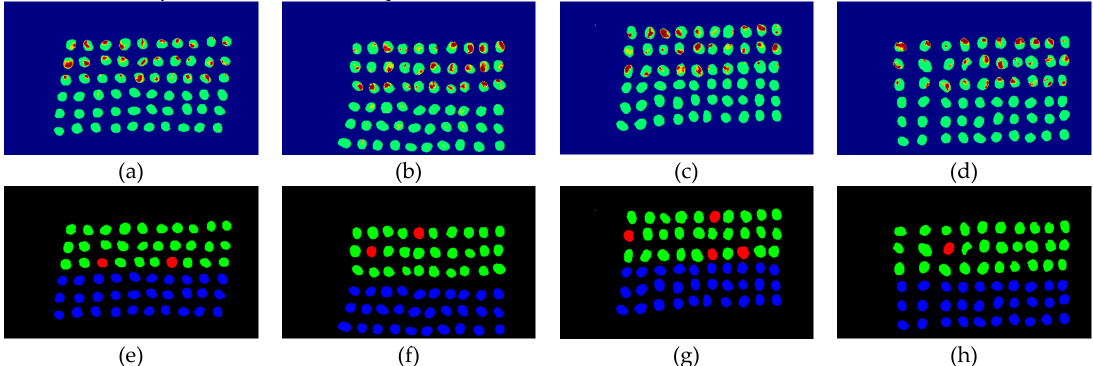
Figure 27. Results of green coffee bean CEM-SVM+CEM_BDM 10 bands. ( a–d ) SVM classification results, ( e–h ) final visual images.